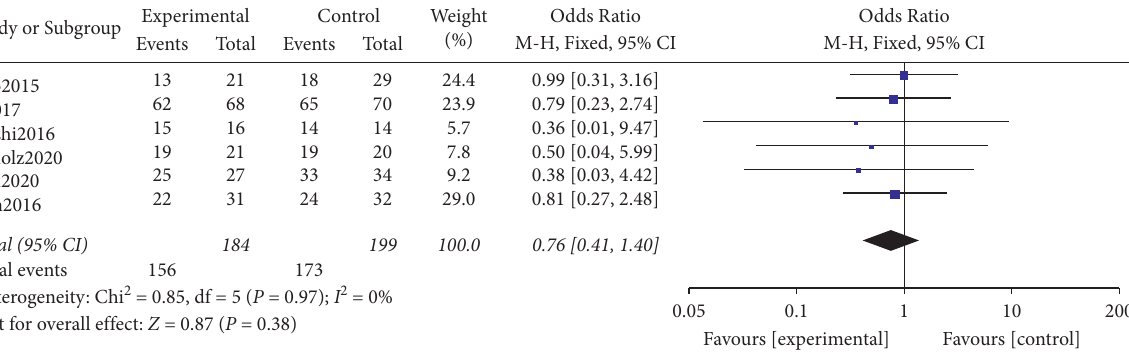
Figure 5: Intervertebral fusion rate.